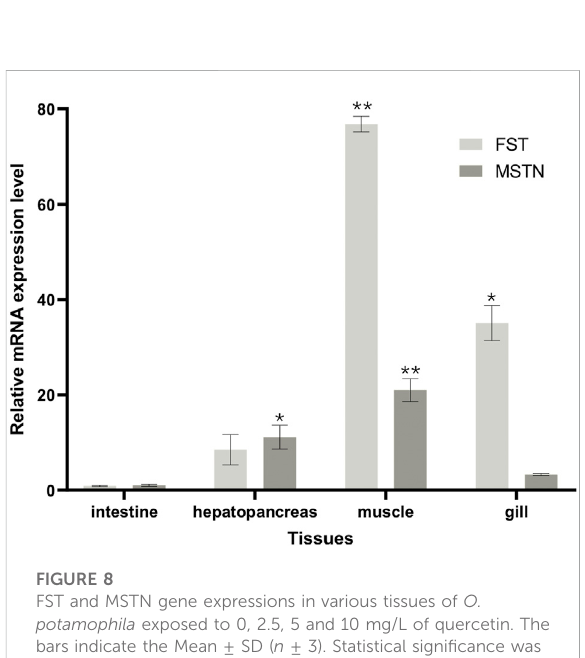
FIGURE 8 FST and MSTN gene expressions in various tissues of O. potamophila exposed to 0, 2.5, 5 and 10 mg/L of quercetin. The bars indicate the Mean ± SD ( n ± 3). Statistical signi fi cance was taken as *( p < 0.05) and **( p < 0.01) compared with the intestine samples.